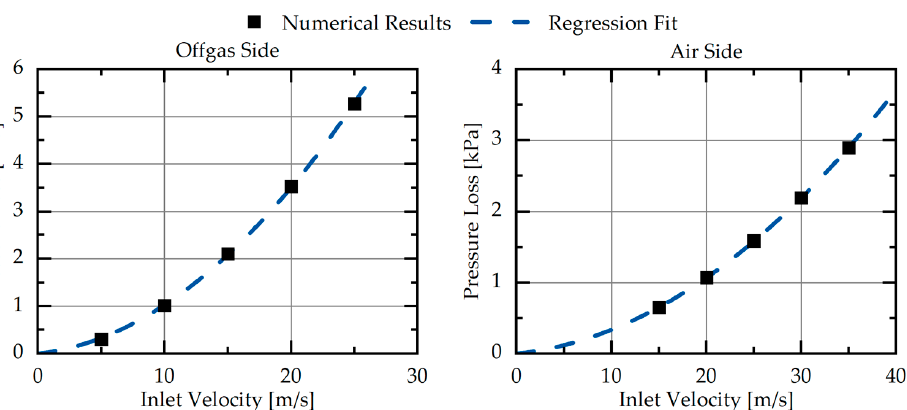
Figure 14. Numerically calculated values for the pressure loss caused by the fins and the resulting regression fit function.